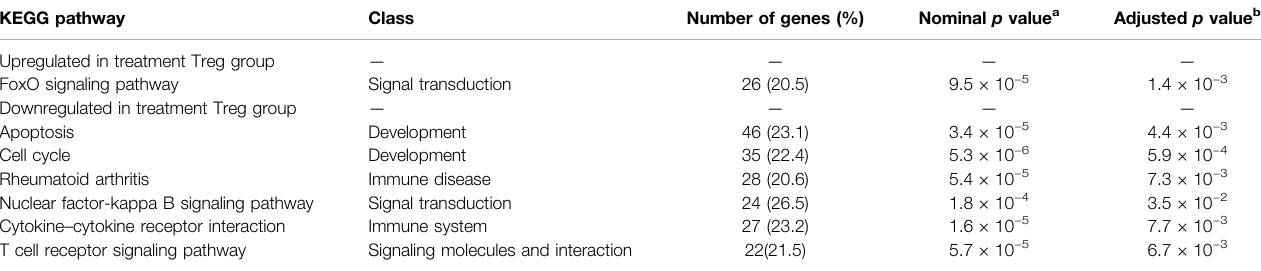
TABLE 2 | KEGG pathways enriched in treatment Treg cells of early treatment-naïve RA